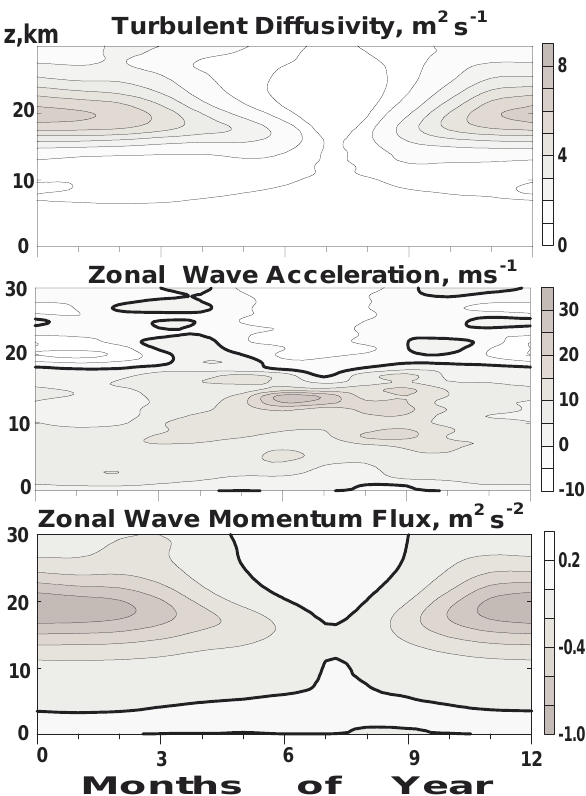
Fig. 6. Calculated distributions of turbulent viscosity (top), wave acceleration of the mean flow (middle) and vertical component of zonal wave momentum flux (bottom). Solid lines correspond to zero